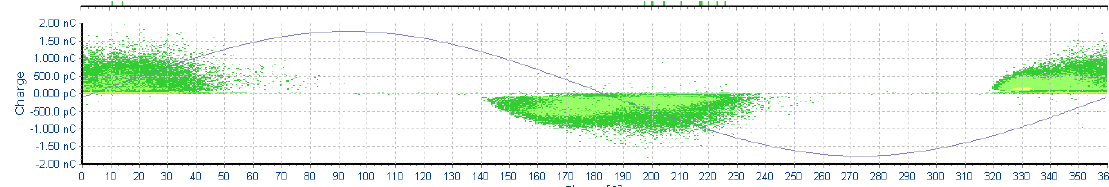
Figure 6. Pattern diagram for partial discharges under 4.5kV rms AC